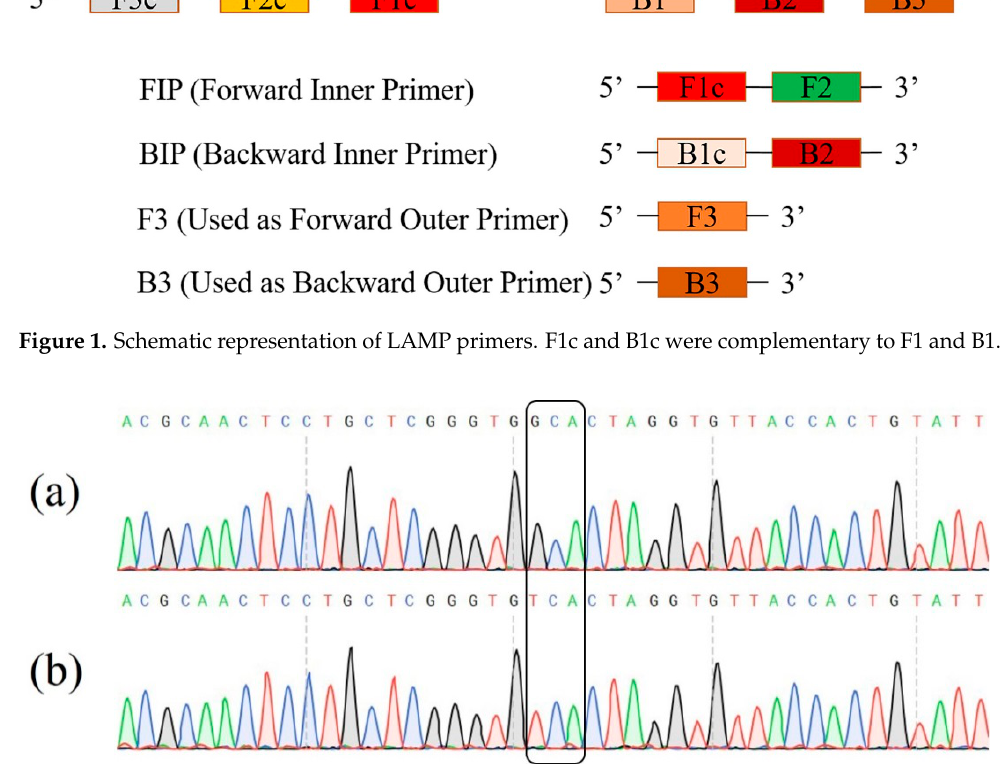
Figure 2. Sequencing results of the mutant plasmid. The ( a , b ) were the CsRDL1 -A282 and CsRDL1- S282, respectively. The nucleotides in the box represent the 282th amino acid of CsRDL1